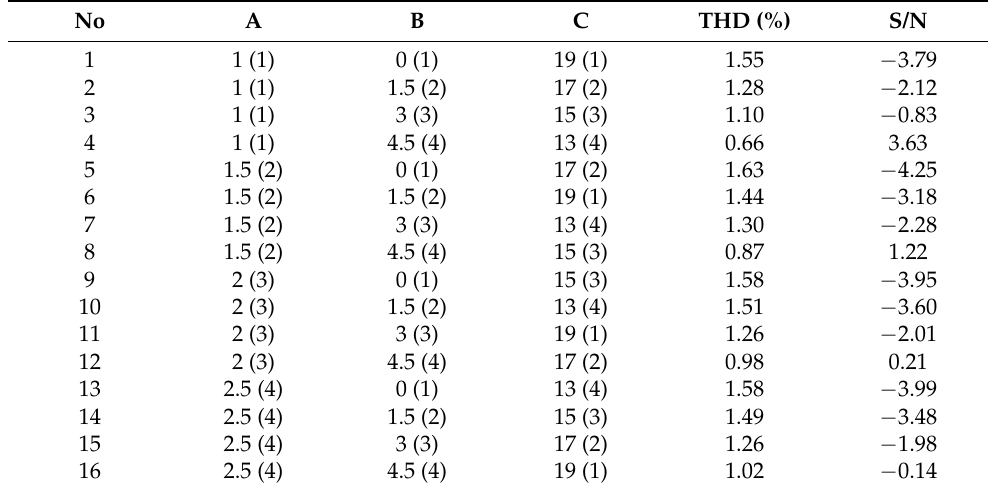
Table 5. Results of L 16 Taguchi